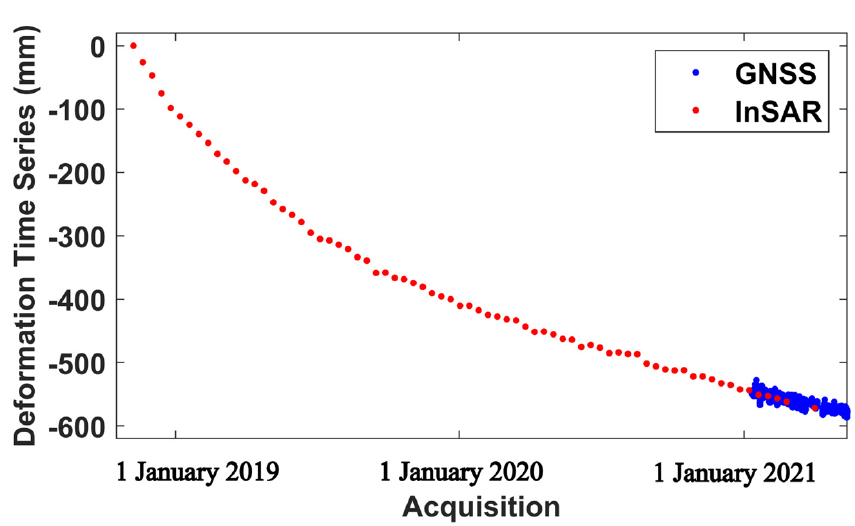
Figure 12. Comparisons of InSAR- (red dot) and GPS LOS-projected (blue dot) deformation time series.